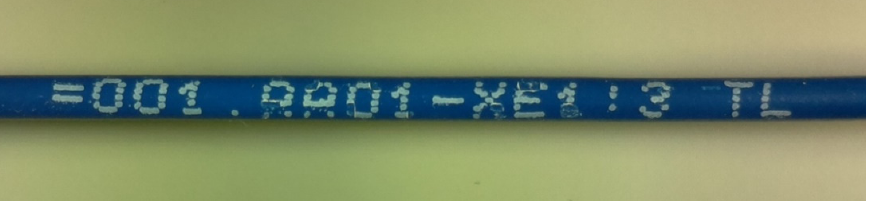
Figure 10. The actual picture taken by the WLR: faultily printed text; the figure was previously published in [10].